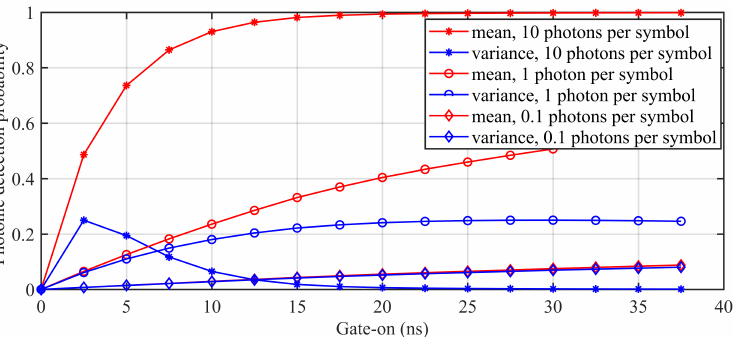
Figure 3. The influence of gate-ON time on the photon detection probability and